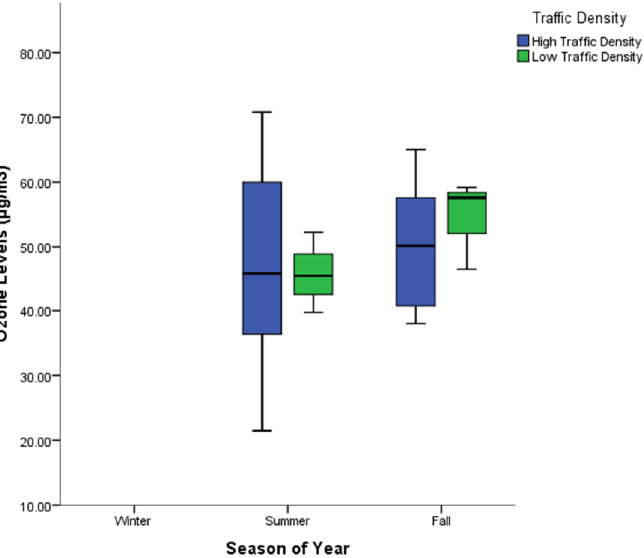
Figure 4. Variations in O 3 concentrations (median) by traffic density during fall and summer.